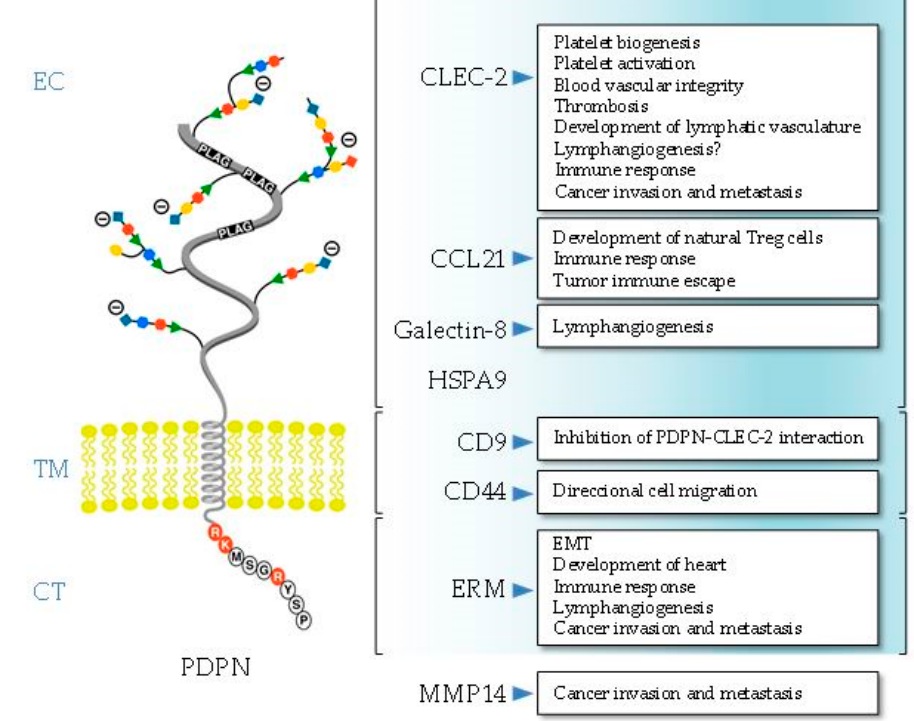
Figure 1. Schematic representation of the structure of human podoplanin (PDPN) showing the amino- acid sequence of the short cytosolic (CT) domain. The ligands and the biological processes in which the interaction with PDPN is involved are presented. The main PDPN structural domain involved in ligand binding is indicated, except for matrix metalloproteinase 14 (MMP14), which is presently unknown. EC, ectodomain; TM, transmembrane region; CT, cytosolic domain. presently unknown. EC, ectodomain; TM, transmembrane region; CT, cytosolic